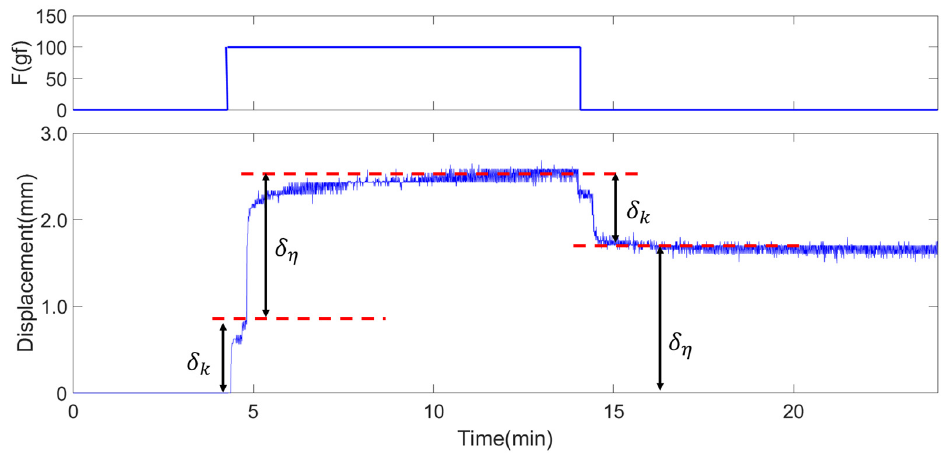
Figure 10. Free end displacement changes in time domain due to viscoelasticity.